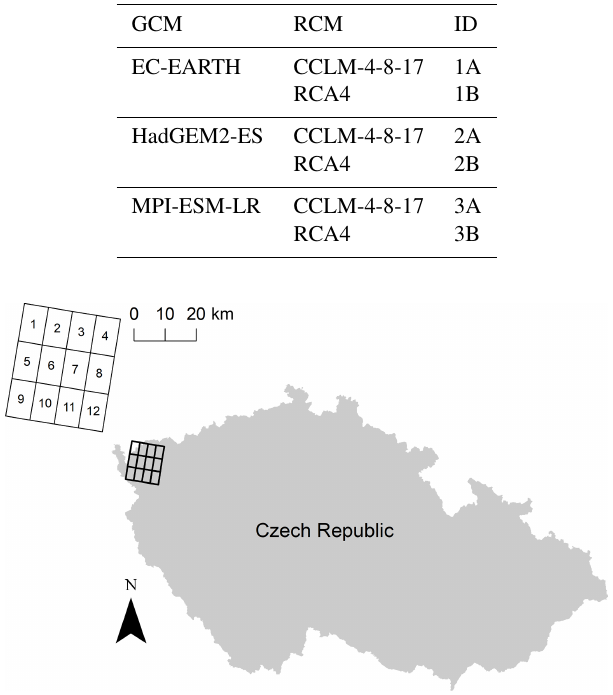
Figure 1. Location of the considered grid boxes in the Czech Re-